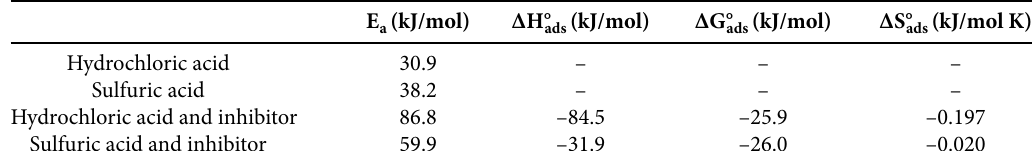
Table 4. Thermodynamic and kinetic parameters for adsorption of inhibitor in sulfuric acid and hydrochloric acid solutions on the metal surface. (Results derived from two repeats of experiment.)